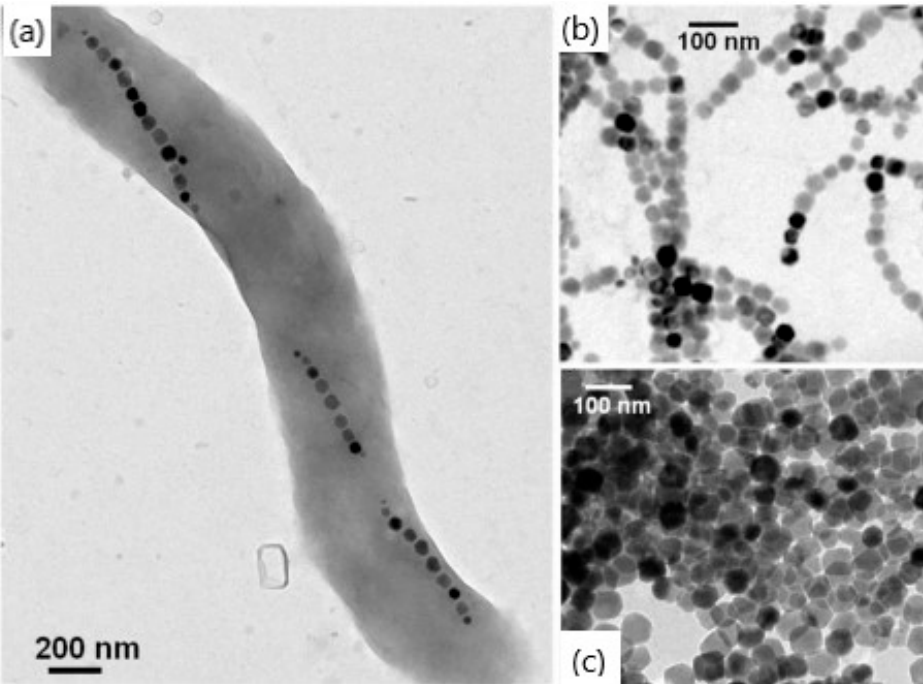
Figure 8. TEM images of a single magnetotactic bacterium ( a ), of chains of magnetosomes extracted from whole magnetotactic bacteria ( b ), and of individual magnetosomes detached from the chains ( c ) (adapted from [74] with permission from 2014 Alphandéry).